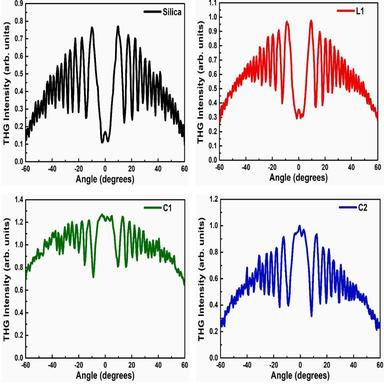
THG intensities versus rotation stage angle of the investigated L1, C1 and C2 thin films compared with the silica reference material in p-p polarized laser beam.